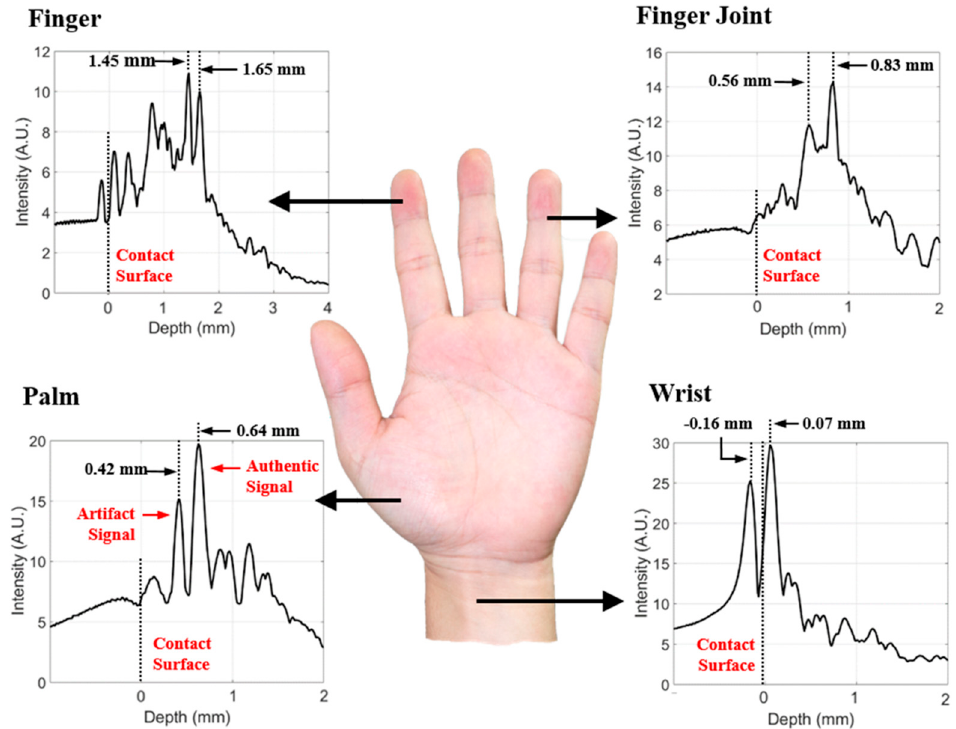
Figure 4. Depth intensity according to body part (finger, finger joint, palm, wrist). Figure 5. Depth intensity according to body part (finger, finger joint, palm,